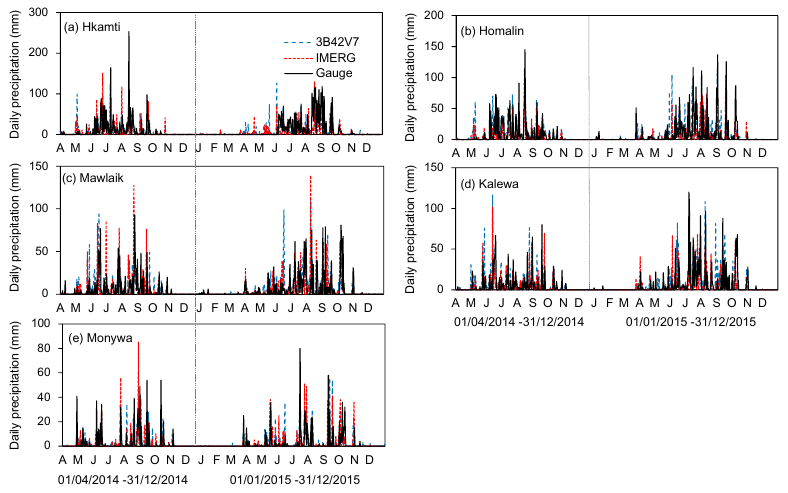
Figure 4. Comparison of daily precipitation estimates from 3B42V7 and IMERG satellite precipitation products at the main weather stations against the gauge-based daily precipitation time series from 1 April 2014 to 31 December 2015. Table 2. Statistical indices of daily precipitation estimates at the five weather stations in the Chindwin River basin (1 April 2014–31 December 2015). Weather Stations Satellite Precipitation Weather